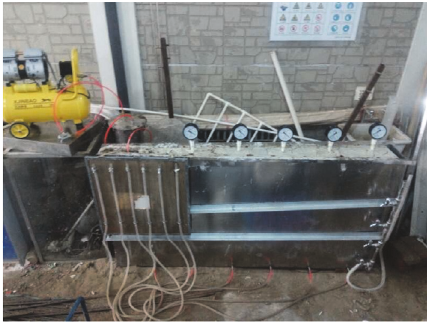
Figure 5: Photograph of the experimental device. Table 1: Distribution of vacuum pressure.